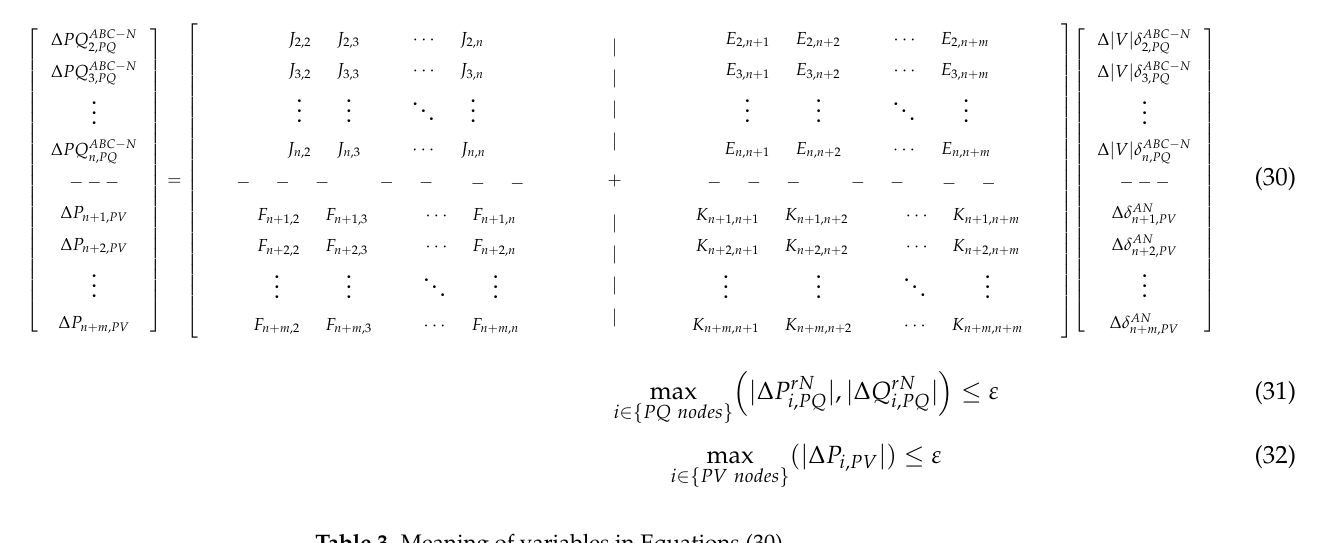
Table 3. Meaning of variables in Equations (30).